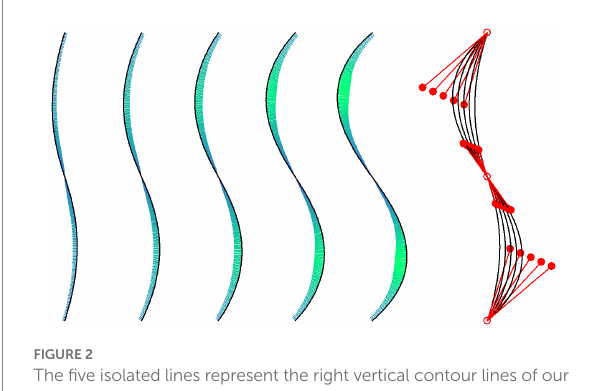
FIGURE 2 The five isolated lines represent the right vertical contour lines of our vase stimuli. The curvature at points along the lines is indicated by the length (scaled for good visibility) and color (redundant coding) of the short lines orthogonal to the tangent at these points. On the right, the five lines are superposed and shown together with their corresponding Bézier control points (empty red dots) and handle points (filled red